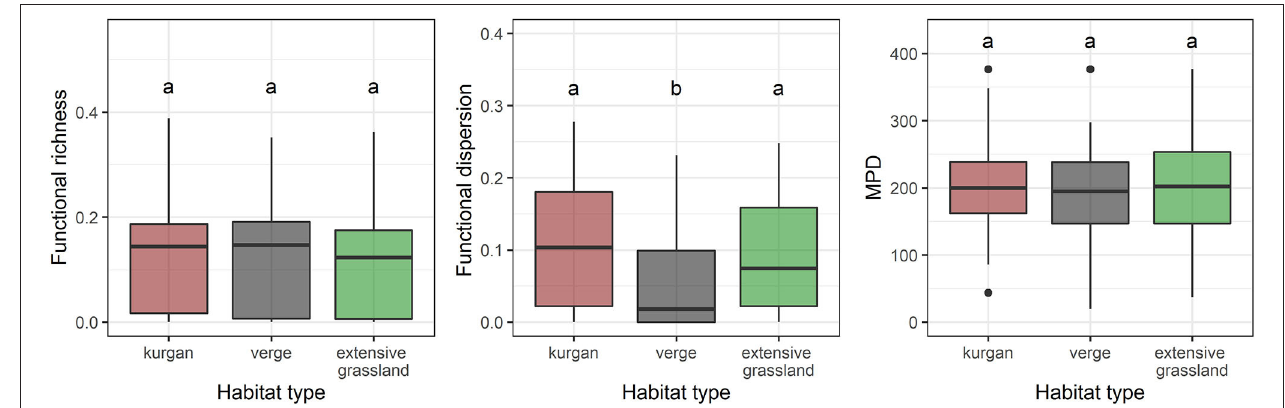
FIGURE 4 | Multi-trait based functional richness (FRic), dispersion (FDis), and mean pairwise phylogenetic distance (MPD) of specialist plant assemblages in the three studied habitat types (kurgans, verges, and extensive grasslands). Boxes, vertical whiskers, bold horizontal lines, and individual dots represent interquartile range (IQR: value range between 25 and 75% quartiles), minimum and maximum value range (excluding outliers), median, and outliers (values being at least 1.5 times the IQR lower than the lower quartile, or 1.5 times IQR higher than the upper quartile), respectively. Different letters denote significant differences between groups (GLMM; p ≤ 0.05 after Tukey’s